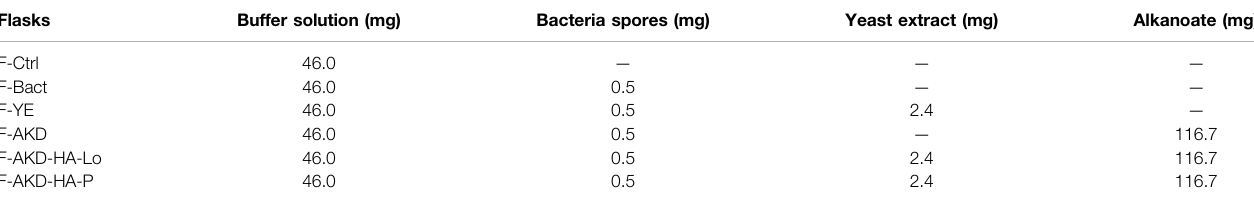
schematically represented in Figure 1 . A complete overview of the whole experimental plan is schematically represented in Figure 3 .